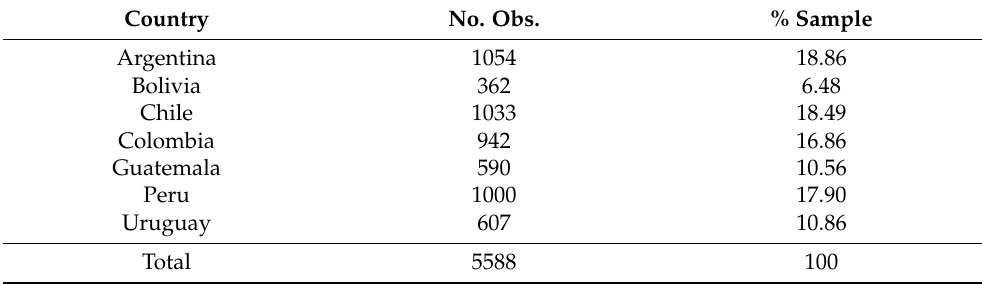
Table 1. Selected countries from the WBES 2010.